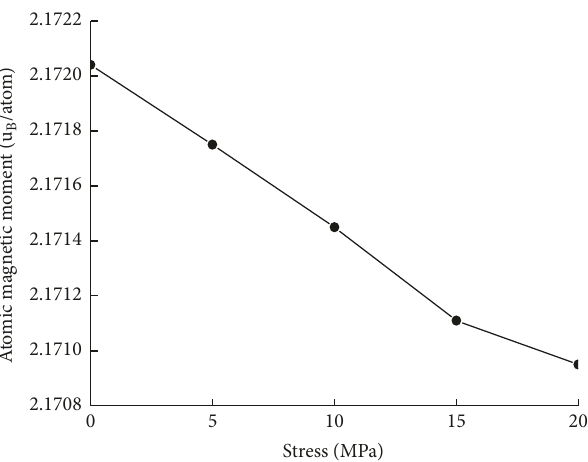
Figure 5: Therelation between atomic magnetic moment and stress.